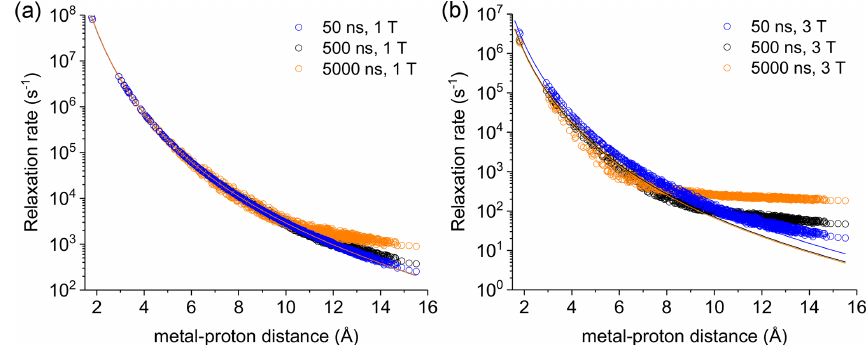
Figure 2. Apparent relaxation rates calculated at 1T (a) and 3T (b) for protons at different distances from a Gd 3 + ion in the macromolecular model with reorientation times of 50, 500, or 5000ns. The lines indicate the Solomon relaxation rates calculated for the same reorientation times (colored accordingly).